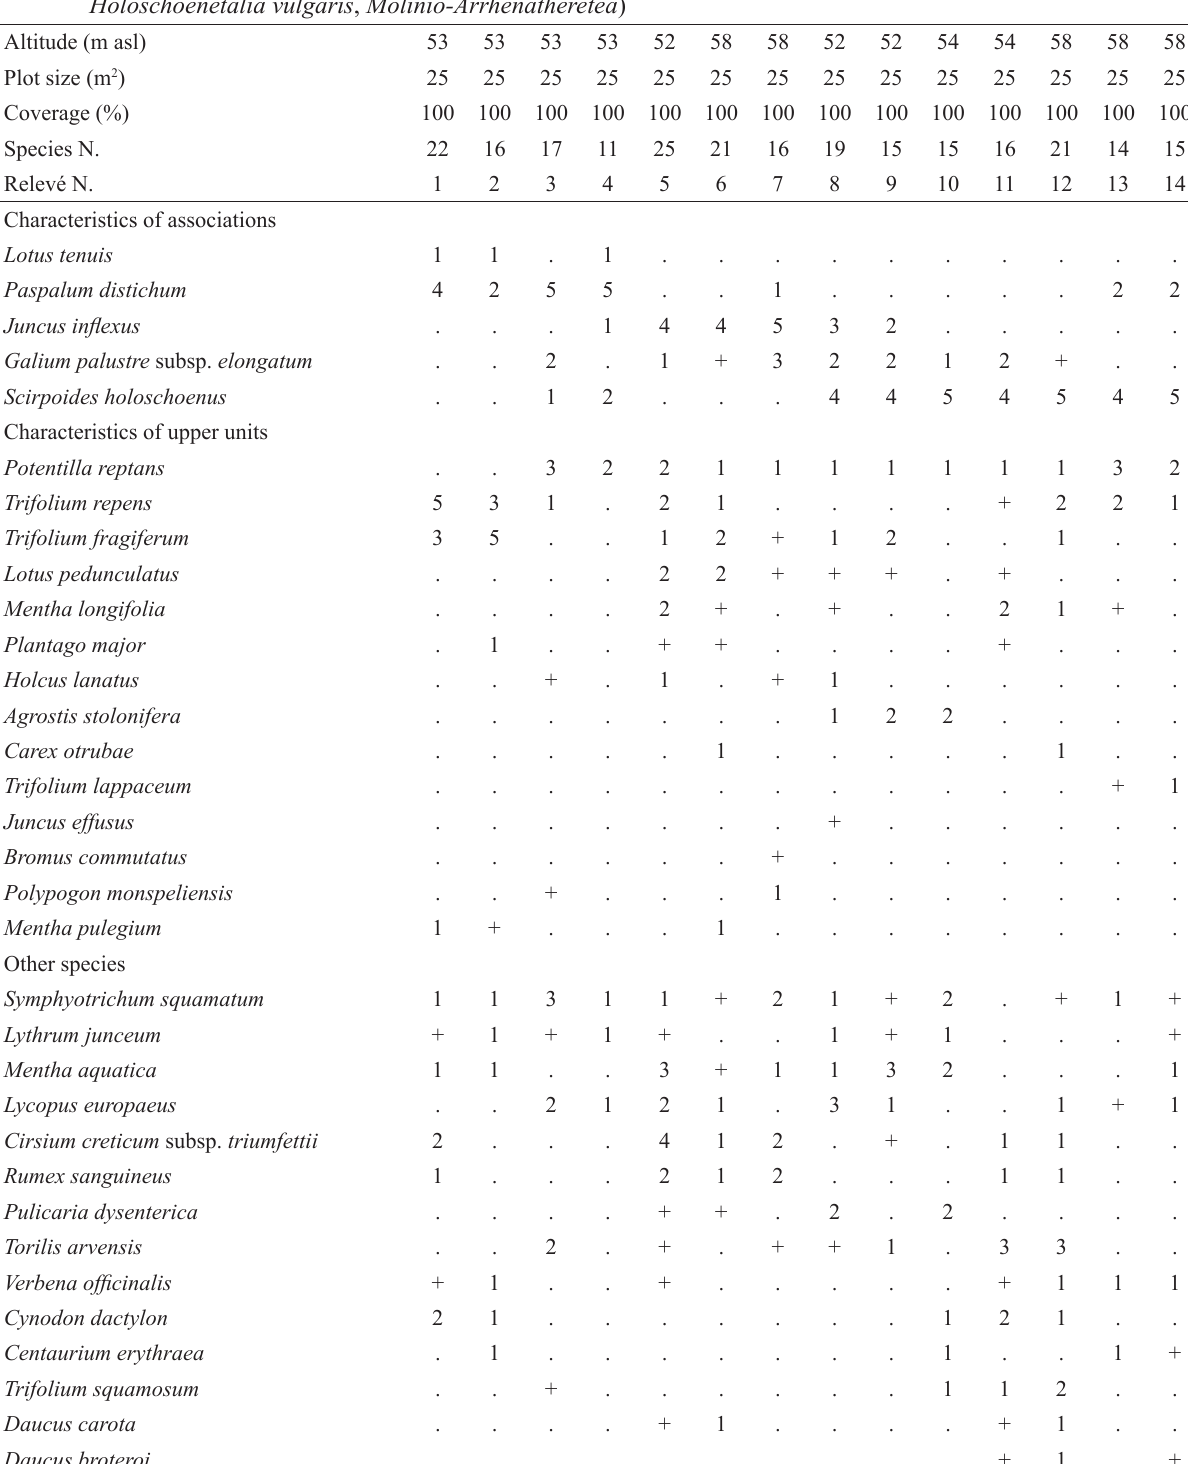
Table 6. Damp meadow vegetation. Loto tenuis-Paspaletum paspaloidis Biondi, Casavecchia & Radetic 2002